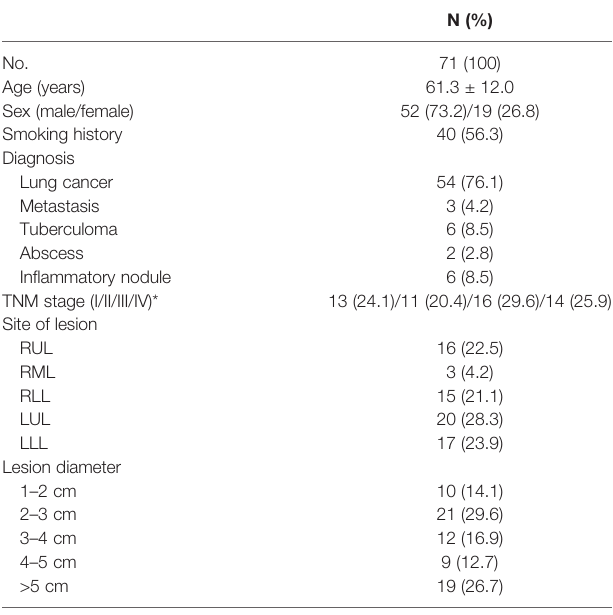
TABLE 1 | Patient characteristics of the study population.